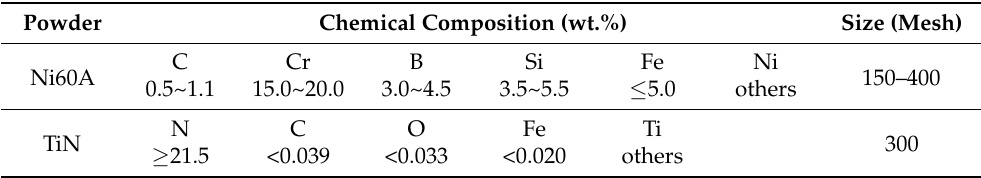
Table 1. Chemical composition and particle size of